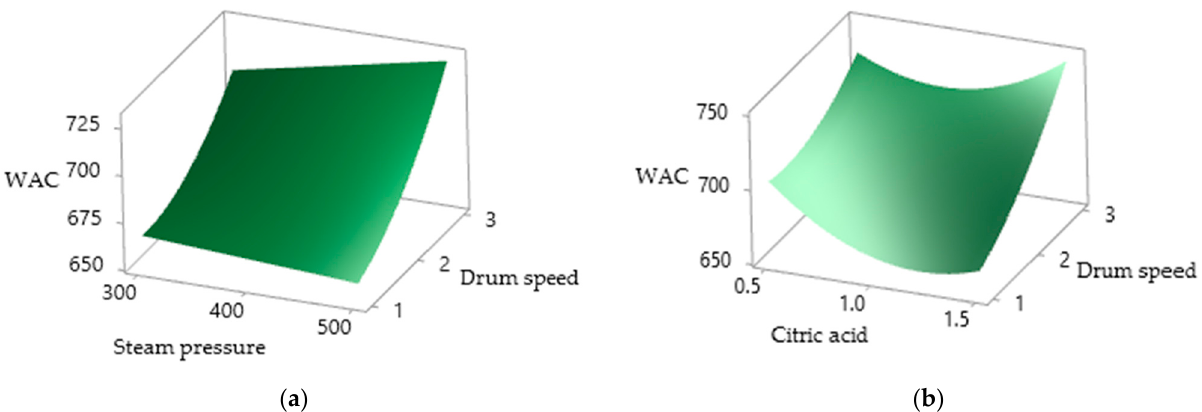
Figure 7. Surface plots of the drum-dried PSPP, WAC as affected by ( a ) SP and DS; ( b ) CA and DS .